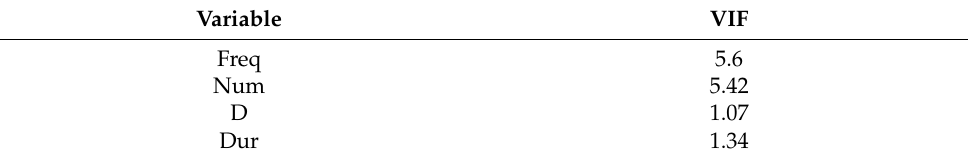
Table 4. Variable Inflation Factor (VIF)